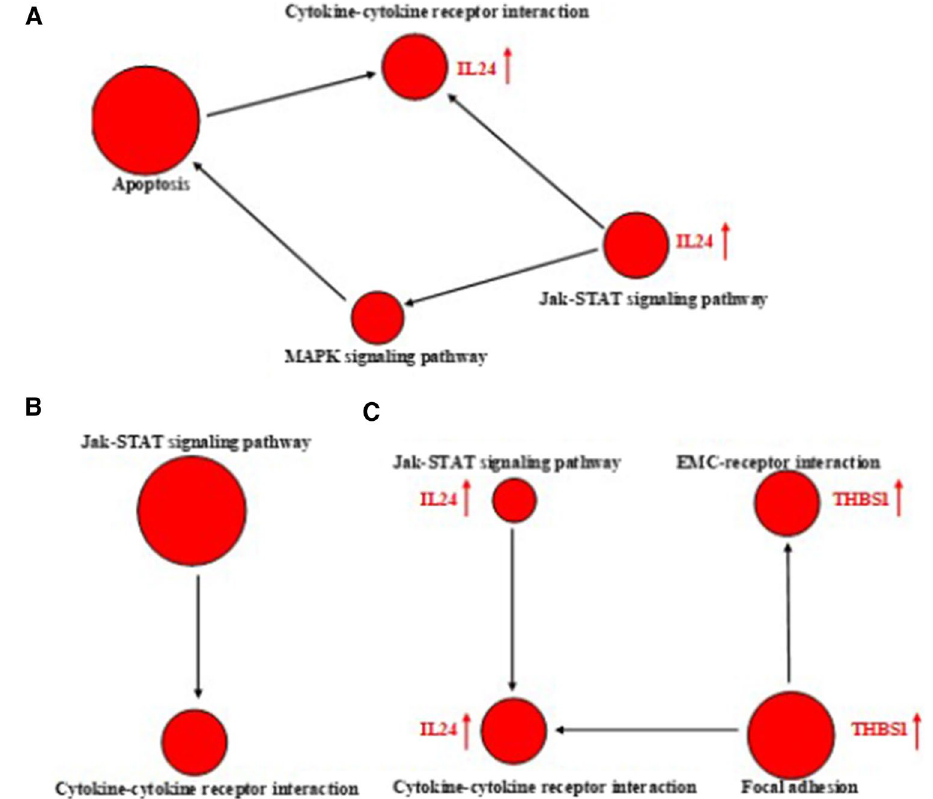
Fig. 6 The signaling pathway networks significantly enriched by KEGG. A Signaling pathway network enriched in LH group. B Signaling pathway network enriched in DDP group. C Signaling pathway network enriched